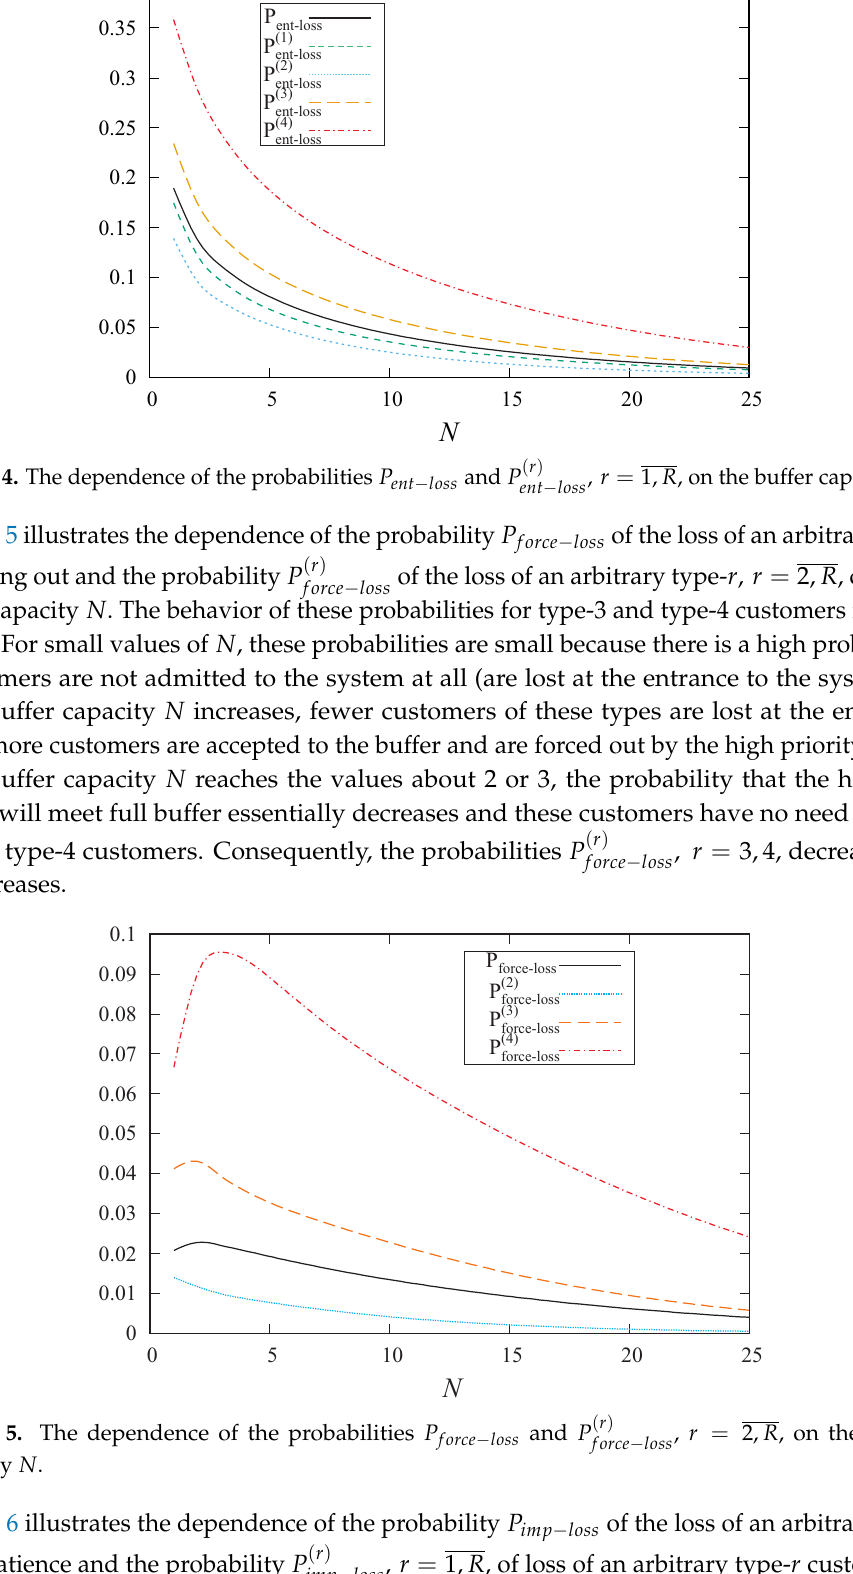
Figure 5. The dependence of the probabilities P force − loss and P capacity N